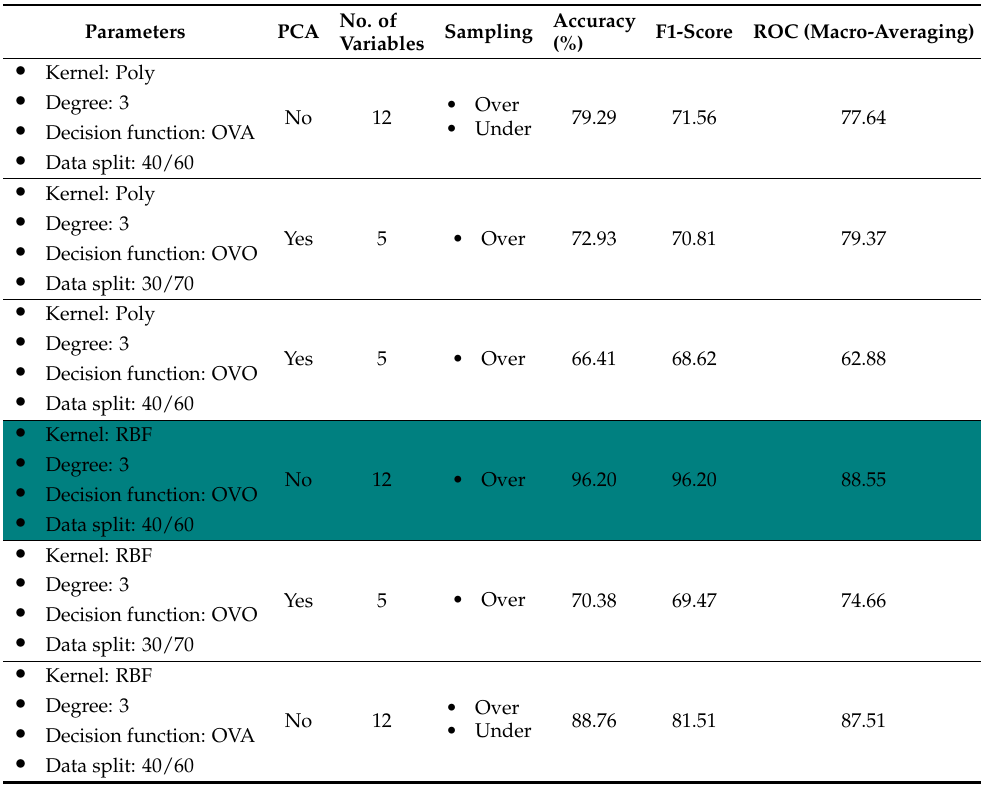
Table 7. The performance of Support Vector Machine classifiers.